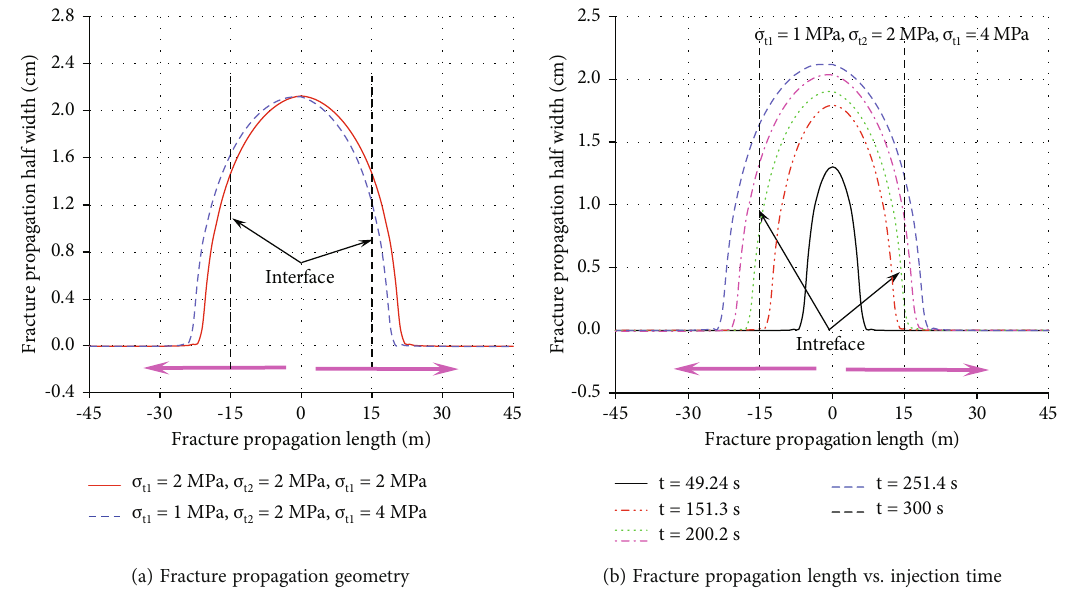
Figure 14: Hydraulic fracture propagates in lower-medium-higher tensile strength layer